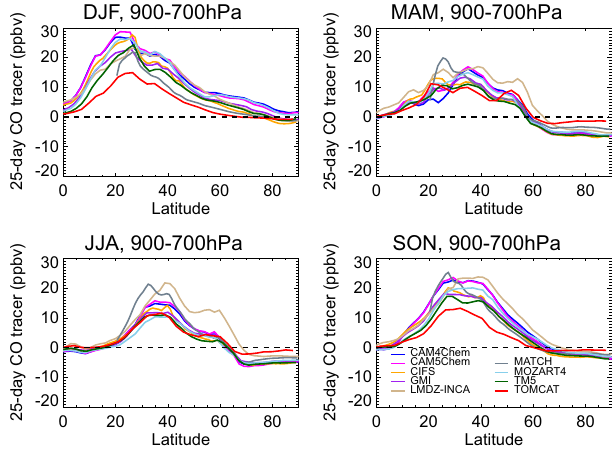
Figure 13. Seasonal zonal mean differences in simulated total 25- day fixed-loss tracer (all six anthropogenic and fire tracers have been summed) between 900 and 700hPa levels. (GEOS-Chem is excluded as the 25-day fixed-lifetime tracers experiments were not